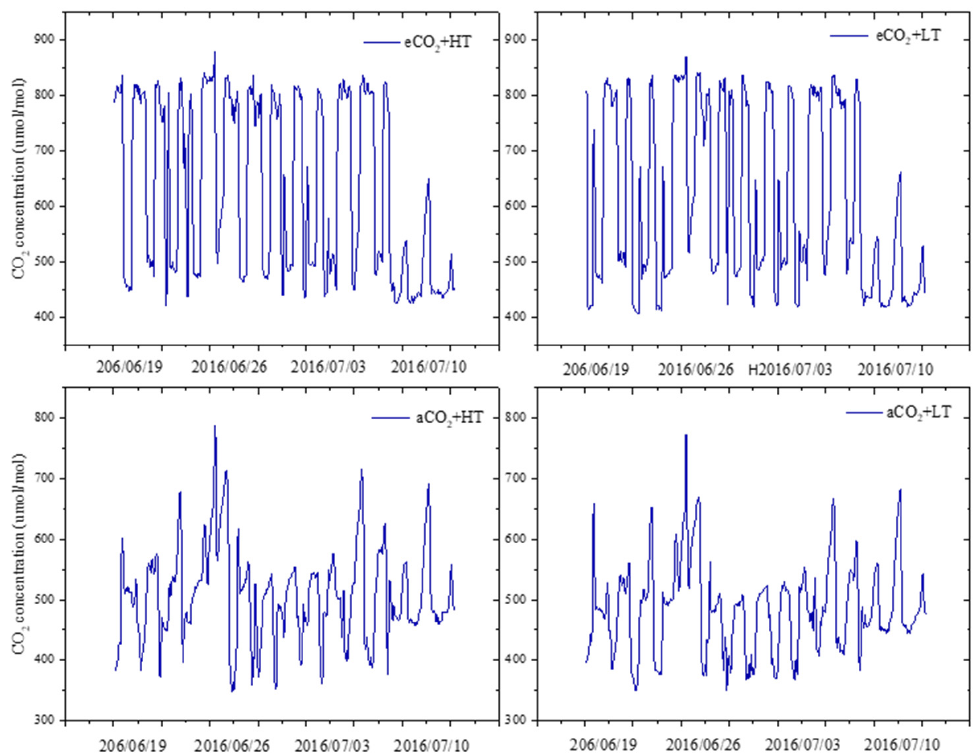
Figure 2. Variations in daily CO 2 levels under aCO 2 + LT, aCO 2 + HT, eCO 2 + LT, and eCO 2 + HT